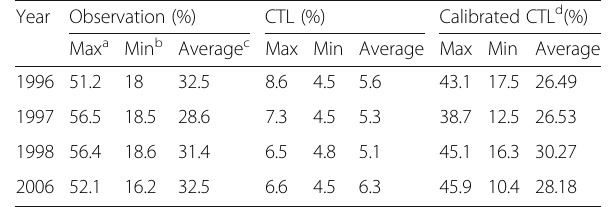
Table 6 Comparison of the percentage of DDE in JJA among 38 rain gauge